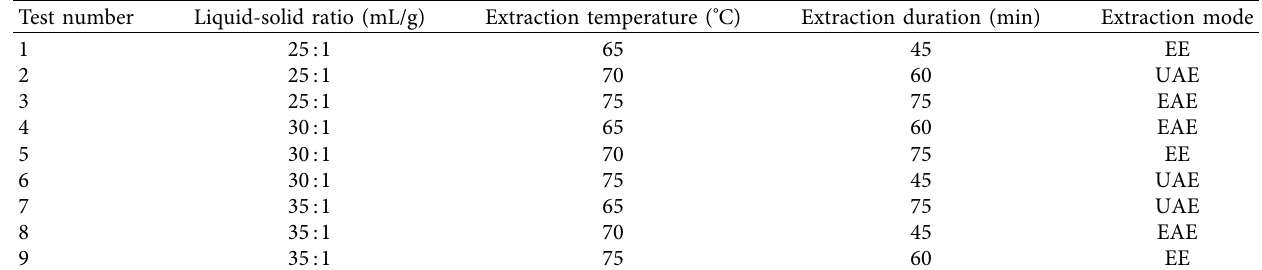
4 ) orthogonal 9 (3